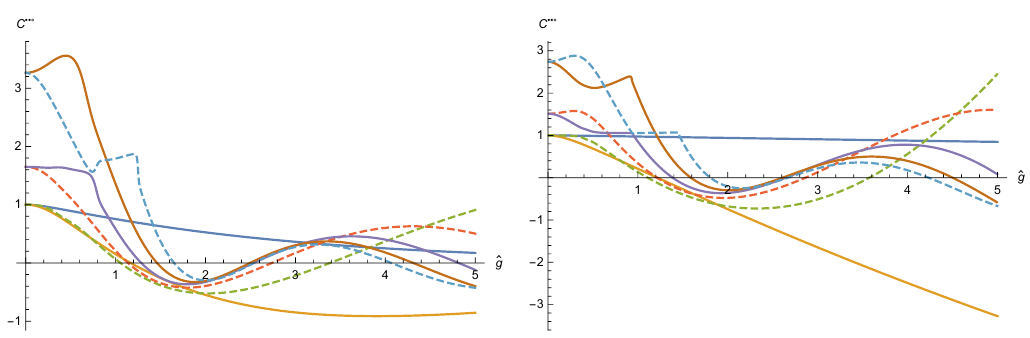
Figure 18 . Diagonal HHL correlator for several (cid:12)rst excited states ( n = 0 ; 1 ; : : : ; 7) with all angles equal to (cid:30) = 1 (left) or (cid:30) = 1 = 3 (right). Colors are the same as on (cid:12)gure